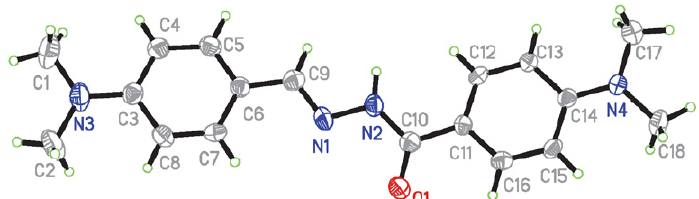
Figure 1. The molecular structure of 1 . The ellipsoids are shown with 30% probability.